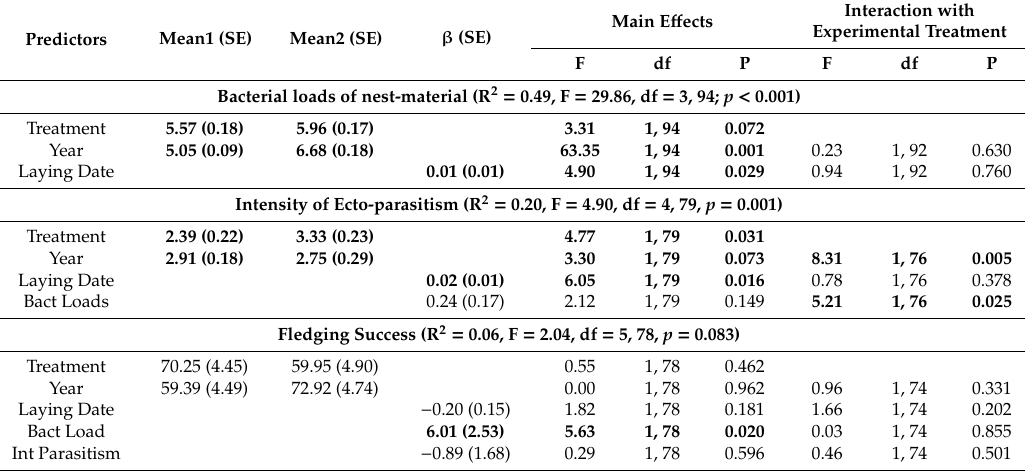
Table 1. Results from general linear models exploring the e ff ect of autoclaving nest-material (Treatment) of nest-boxes that hoopoes bred on: log10-transformed bacterial loads of experimental nest-boxes during hoopoes’ reproduction, the intensity of parasitism (i.e., square root transformed number of bites), fledging success